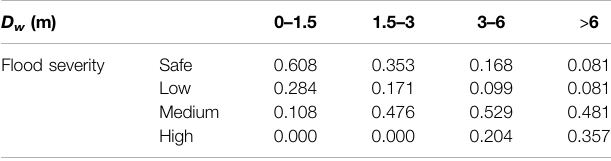
TABLE 2 | The prior conditional probability table of fl ood severity using HURAM (Peng and Zhang, 2012b). D w (m) 0 – 1.5